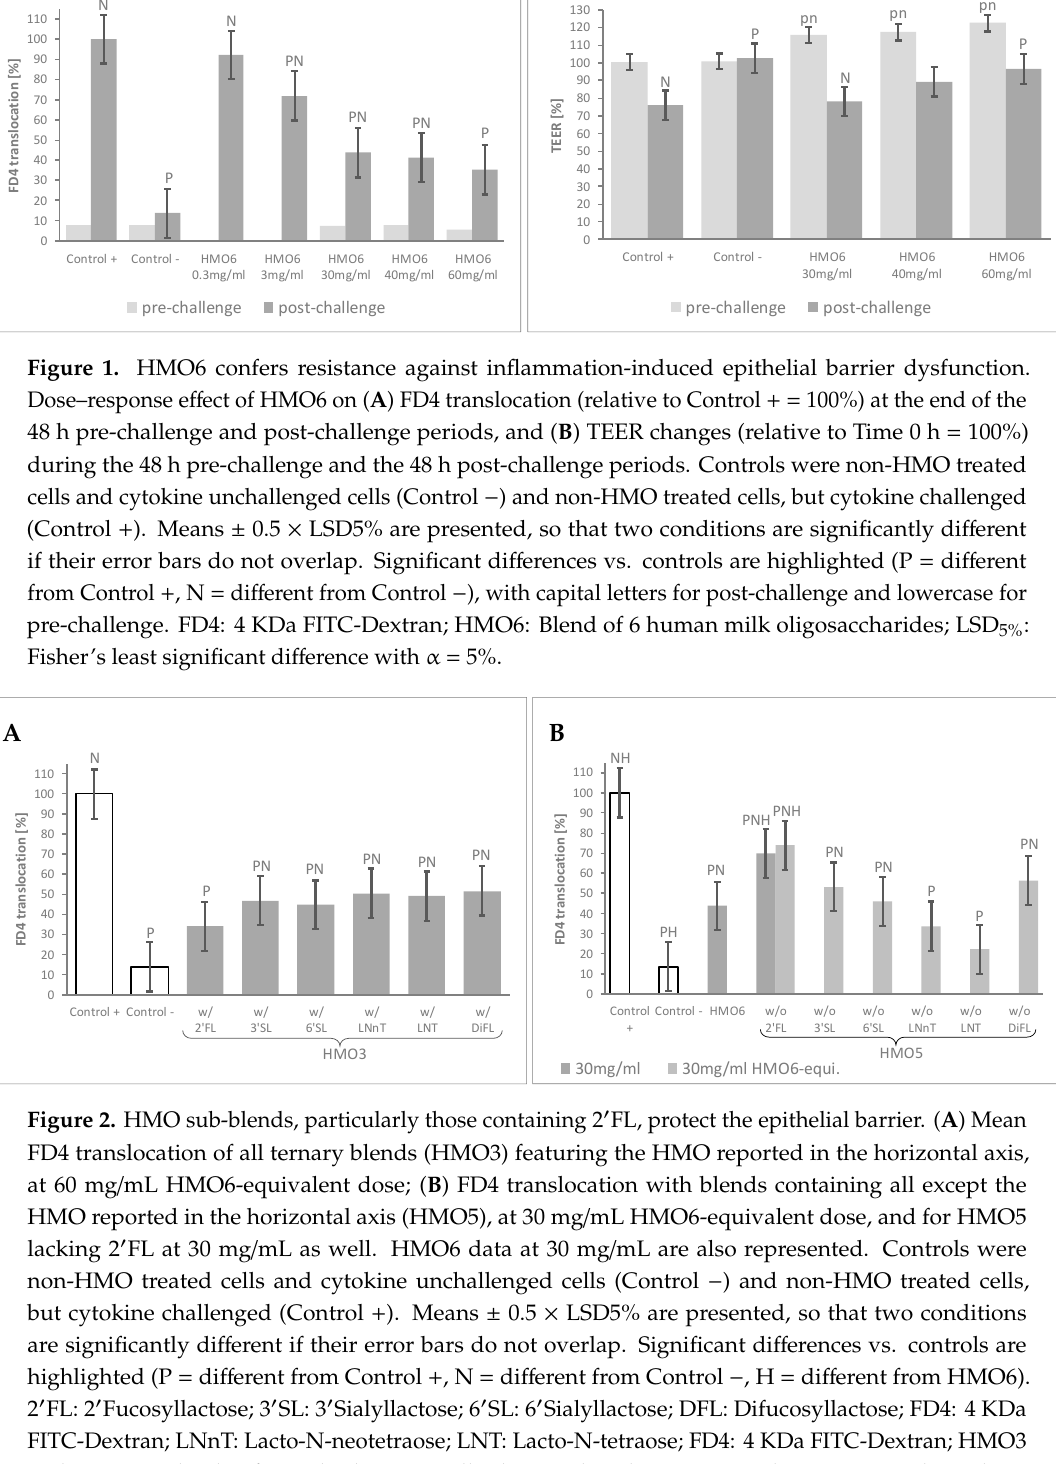
Figure 2. HMO sub-blends, particularly those containing 2 ′ FL, protect the epithelial barrier . (A) Mean FD4 translocation of all ternary blends (HMO3) featuring the HMO reported in the horizontal axis, at 60mg/mL HMO6-equivalent dose; ( B ) FD4 translocation with blends containing all except the HMO reported in the horizontal axis (HMO5), at 30 mg/mL HMO6-equivalent dose, and for HMO5 lacking 2 ′ FL at 30 mg/mL as well. HMO6 data at 30 mg/mL are also represented. Controls were non-HMO treated cells and cytokine unchallenged cells (Control –) and non-HMO treated cells, but cytokine challenged (Control +). Means ± 0.5 x LSD5% are presented, so that two conditions are significantly different if their error bars do not overlap. Significant differences vs. controls are highlighted (P = different from Control +, N = different from Control − , H = different from HMO6). 2 ′ FL: 2 ′ Fucosyllactose; 3 ′ SL: 3 ′ Sialyllactose; 6 ′ SL: 6 ′ Sialyllactose; DFL: Difucosyllactose; FD4: 4 KDa FITC-Dextran; LNnT: Lacto-N-neotetraose; LNT: Lacto-N-tetraose; FD4: 4 KDa FITC-Dextran; HMO3 and HMO5: Blends of 3 and 5 human milk oligosaccharides, respectively; LSD 5% : Fisher’s least significant difference with α = 5%.